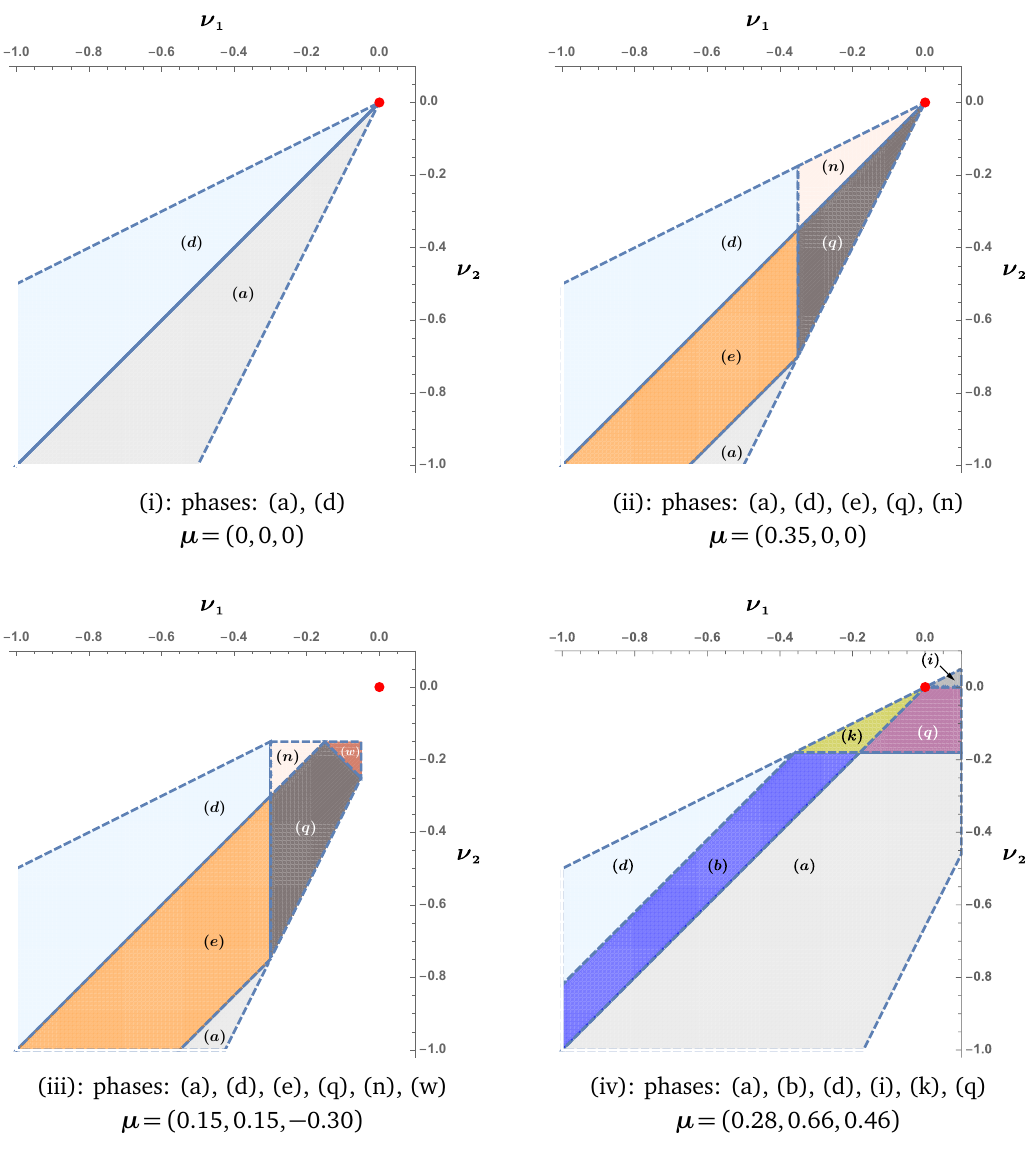
Figure 33: Sample slices of the moduli space of the beetle geometry. In (i) we see the Coulomb Branch of the beetle SCFT, where chambers (b) and (e) degenerate along the wall. Turning on distinct mass deformations can open up distinct gauge theory phases, some of which may be connected to the origin as in (ii) and (iv), but also non-gauge theoretic phase such as (w) in